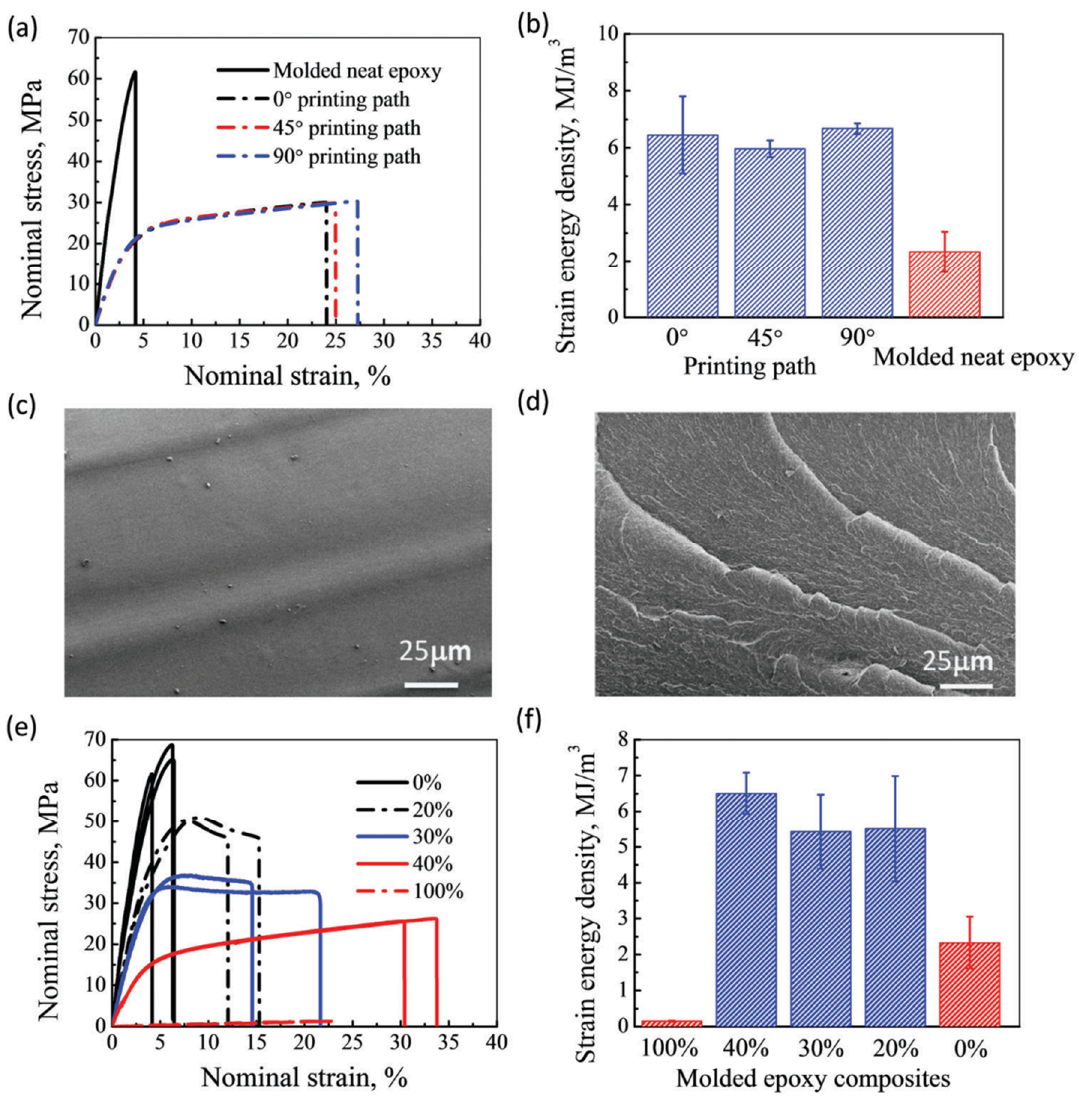
Figure 11. ( a , b ) The stress–strain curves and strain energy density of the molded neat epoxy and print epoxy composites with different printing paths, respectively; ( c , d ) the SEM of the fracture surface of the molded neat epoxy and print epoxy composite material with 0° printing path, respectively; ( e , f ) the stress–strain curves and the strain energy density of molded epoxy composites with different weight fractions of photopolymer, respectively. Percentage is for the photocurable resin. Reproduced from [66] with permission with permission from the Royal Society of Chemistry.